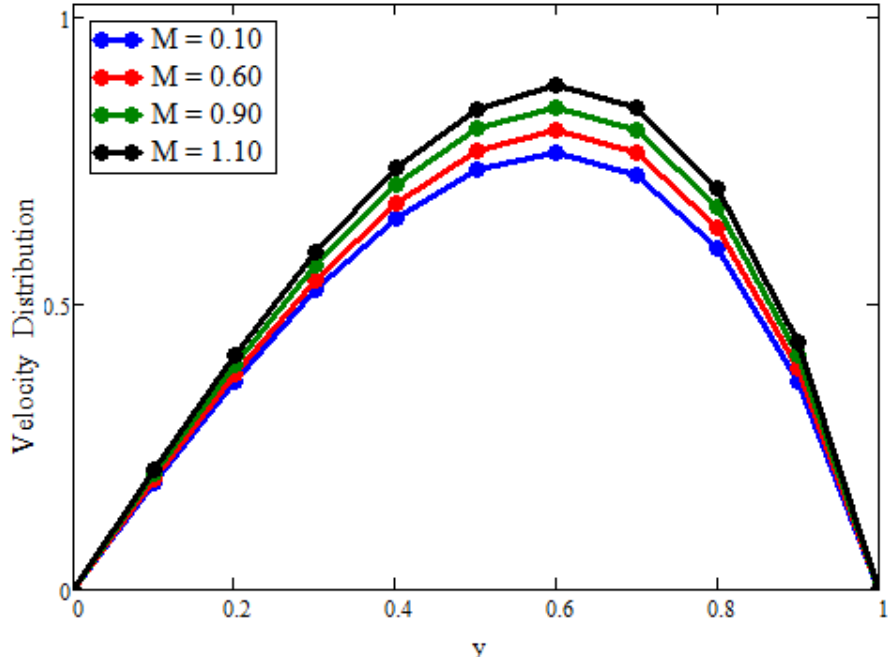
Figure 13. Velocity distribution against y due to M , when Pr = 6.2, φ hnf = 0.04, t = 3, Gr = 15, α = β = γ = 0.5 .